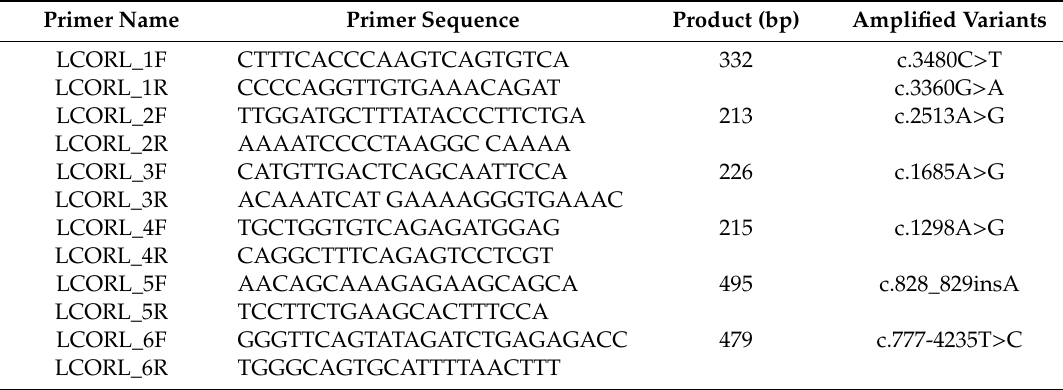
Table 2. Primer sequences to amplify seven LCORL variants. The first amplicon contains two variable